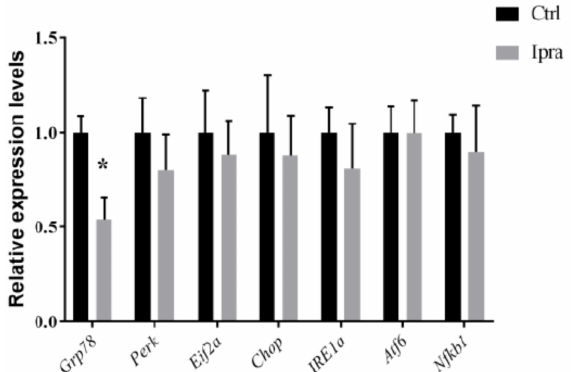
Figure 4. Endoplasmic reticulum stress-associated gene expressions. Relative gene expression levels of Grp78, Perk, Eif2a, Chop, Ire1a, Atf6, and Nfkb1 as quantified by quantitative reverse transcription-polymerase chain reaction (RT-qPCR) in kidney tissues from FLS- ob / ob mouse. Beta-actin was used as an internal control. Levels are expressed relative to control group. Bars indicate average ± SEM. * p < 0.05 (unpaired t -test). Ctrl, control group; Ipra, ipragliflozin group.